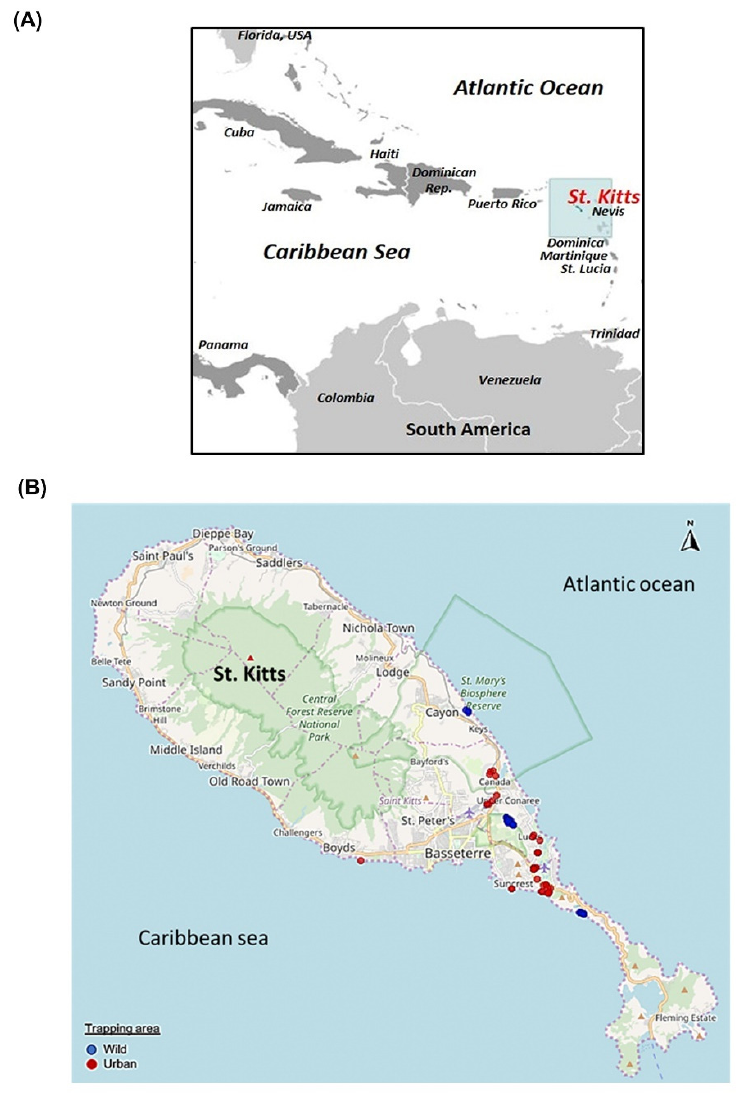
Figure 1. ( A ) Geographical location of the Caribbean island of St. Kitts. The map in Figure 1A was obtained from https://www.cia.gov/library/publications/the-world-factbook (accessed on 1 April 2021). ( B ) Map of St. Kitts showing the mongoose trapping sites. The trapping sites in the wild and urban habitats are shown with blue and red, respectively. The figure originally appeared in Kleymann et al., 2020 [44], and was used here with permission from the corresponding author of the publication